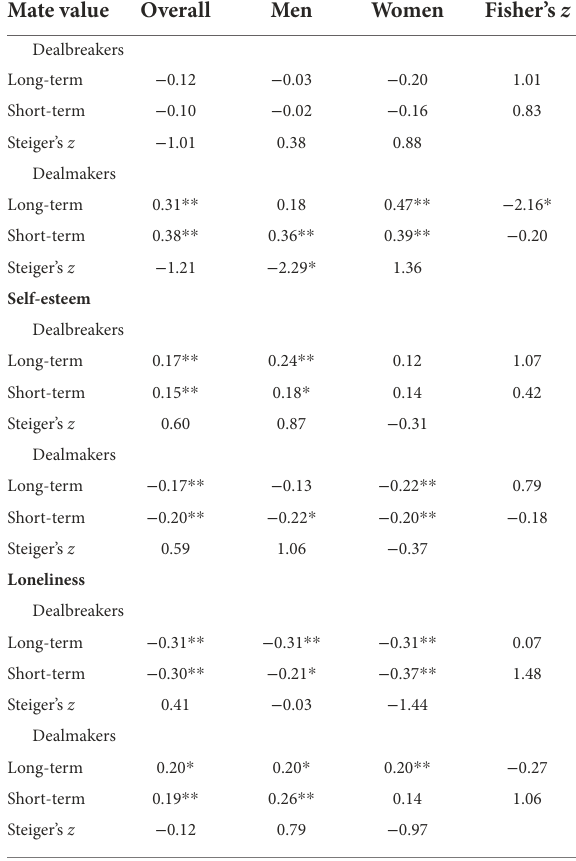
TABLE 2 Correlations for self-perceived mate value, self-esteem, and loneliness and interest with mates with dealmakers and dealbreakers in short-term and long-term mating contexts and within men and women (Studies 1 and